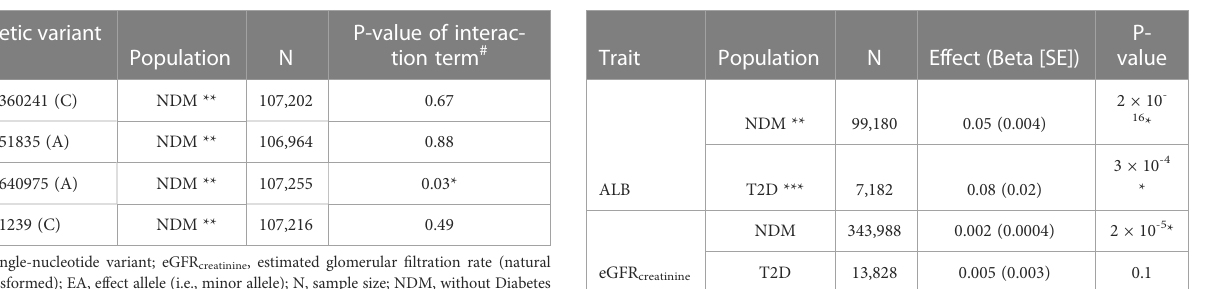
TABLE 6 Summary results for GRS CUBN -eGFR creatinine and -ALB analyses in UKBB (model 1).